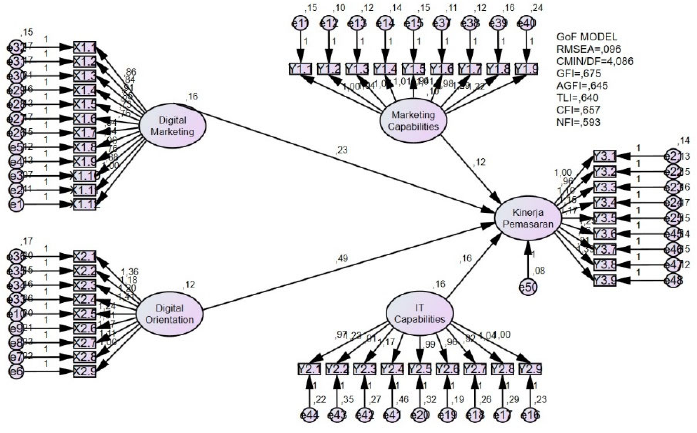
Fig. 2. Structural model for testing the